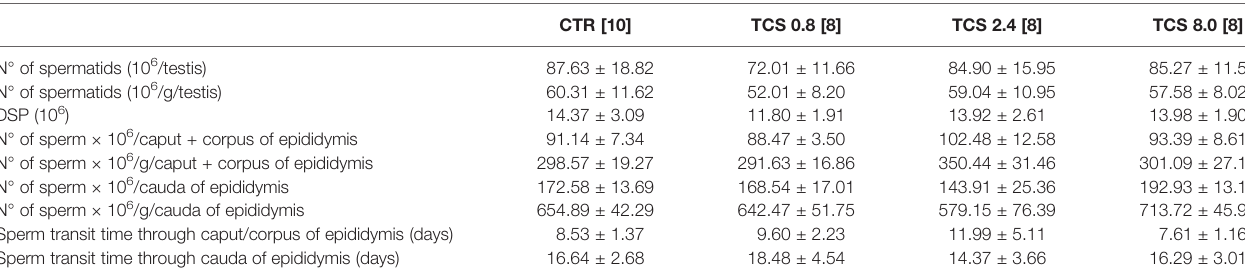
TABLE 4 | Sperm count in the testis and epididymis of male rats of F1 generation at PND 140.